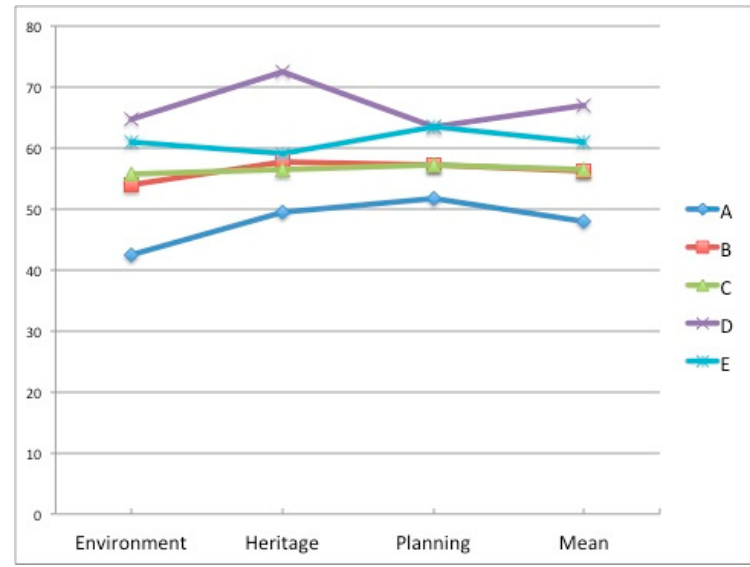
Figure 8. Overall preference of the alternatives from the three experts.